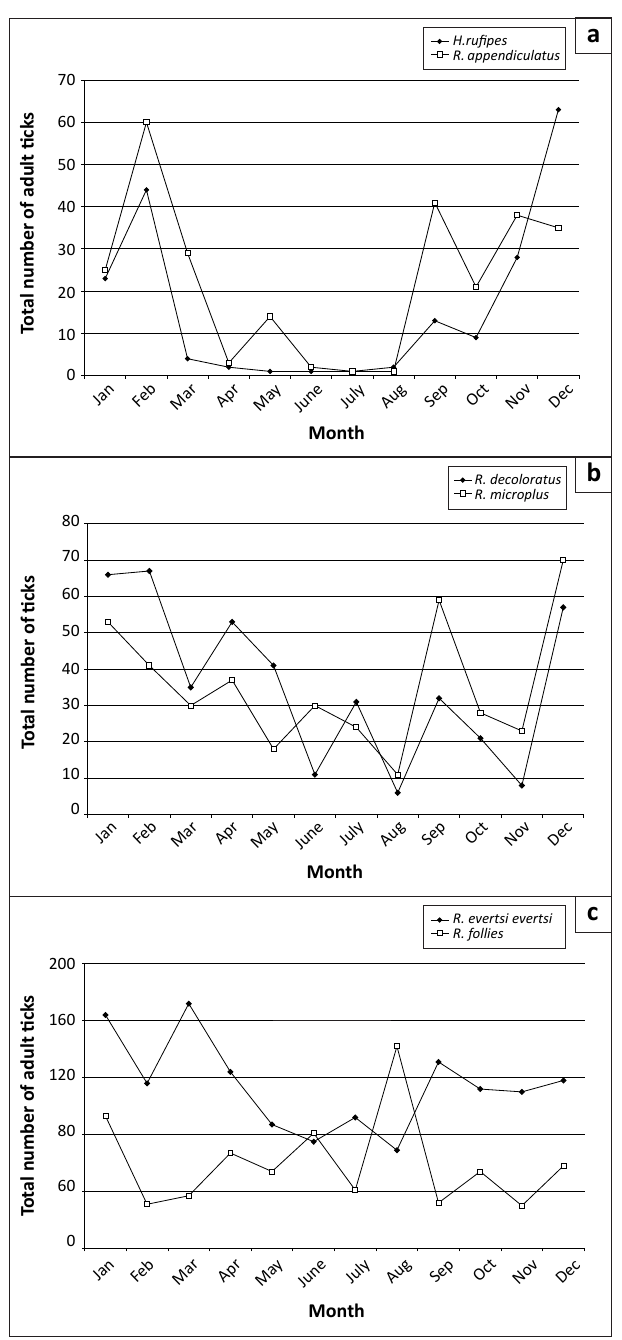
FIGURE 5: Composite seasonal abundance of adult (a) Hyalomma rufipes and Rhipicephalus appendiculatus , (b) Rhipicephalus decoloratus and Rhipicephalus microplus , and (c) Rhipicephalus evertsi evertsi and Rhipicephalus follis on cattle at Döhne and Campagna (February 2007 – January 2010).